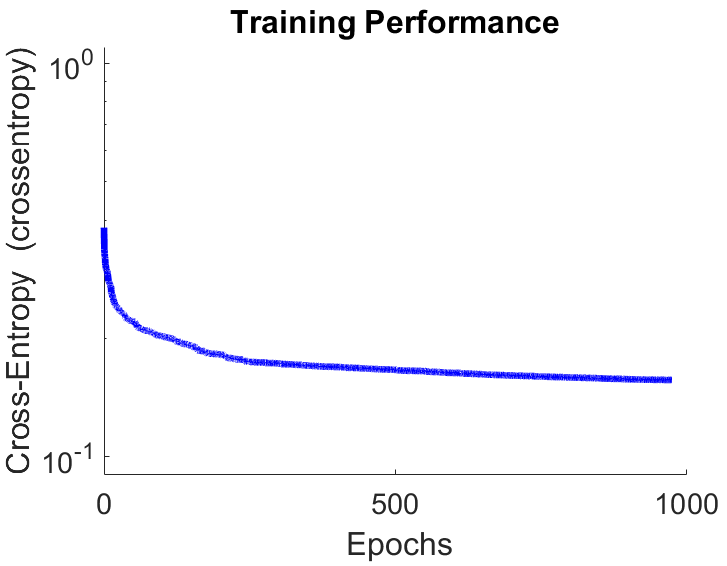
Figure 12. Training plot of the proposed MLP 1